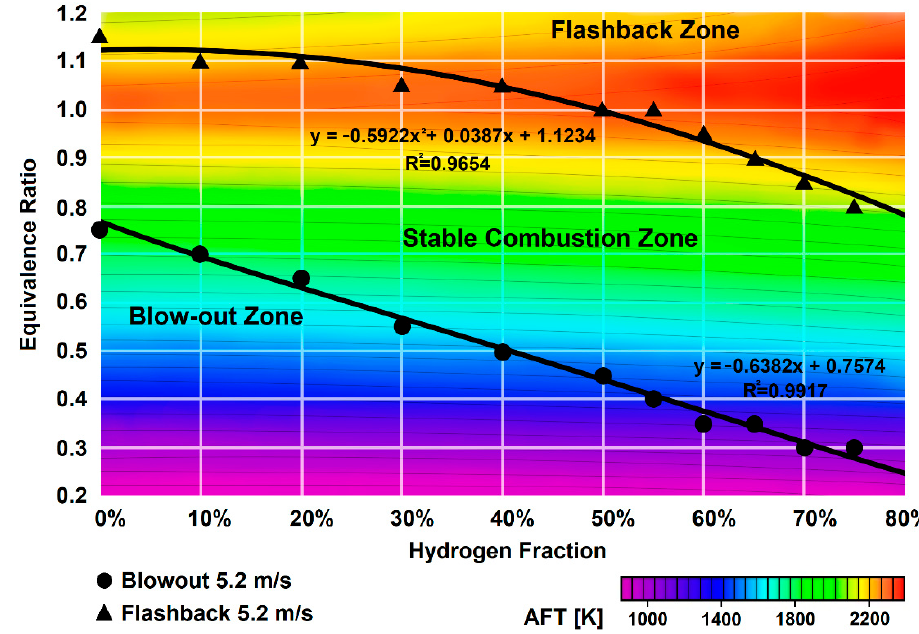
Figure 24. The influence of the volume concentration of hydrogen on the boundary of sustainable combustion for the lean flame blowout and flashback [28].